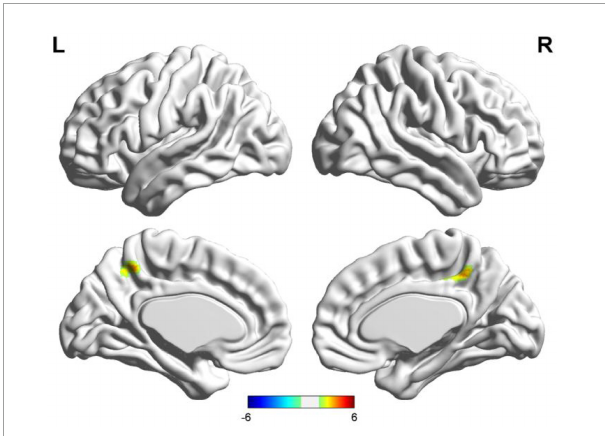
FIGURE5 Results of two-sample t -test of language lateralization in terms of Broca’s area (the seafarer group > the non-seafarer group; p 0.005, cluster size > 200 voxels, corresponding to corrected p FWE 0.05). R: right hemisphere, L: left